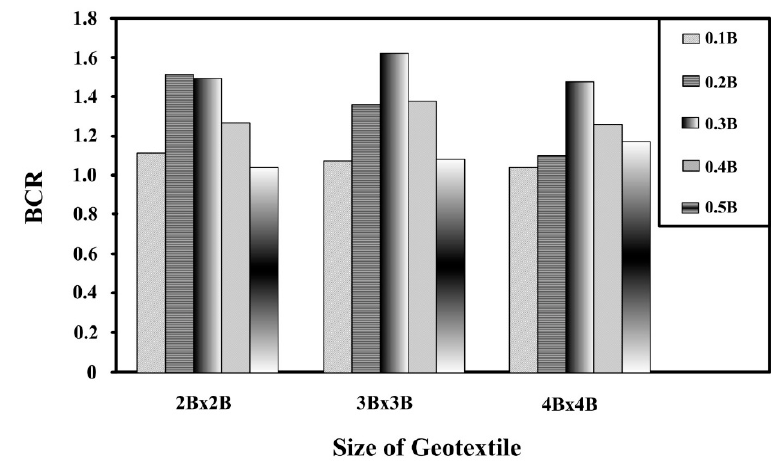
Figure 10. Bearing capacity ratio with geotextile placed at a depth 0.1B to 0.5B below footing (modified from Kumar et al. [33]).